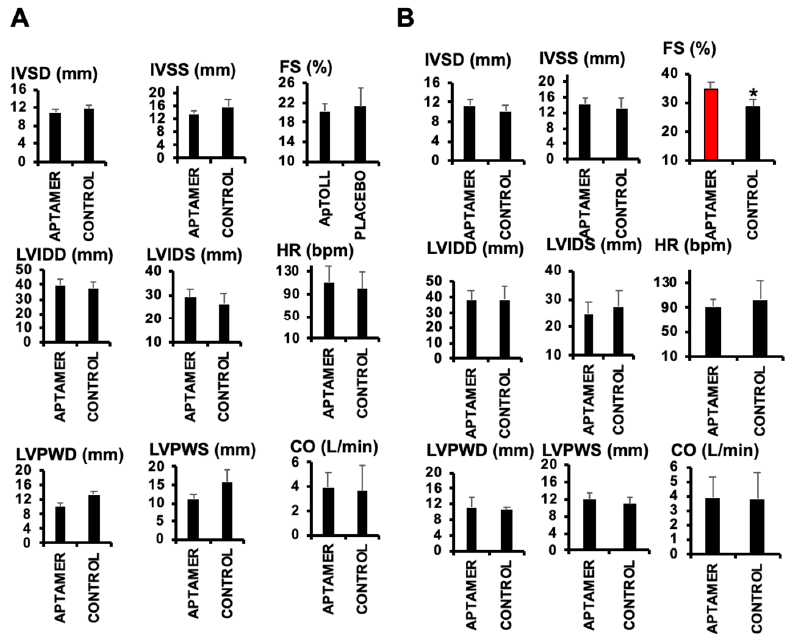
Figure 2. Echocardiographic parameters collected by day 3 ( A ) and day 7 ( B ), respectively, after IR. (N = 9 ApTOLL/8 Placebo. Mean ± SD. EF: * p < 0.0006 ApTOLL vs. Placebo. FS: * p < 0.003 ApTOLL vs. Placebo).